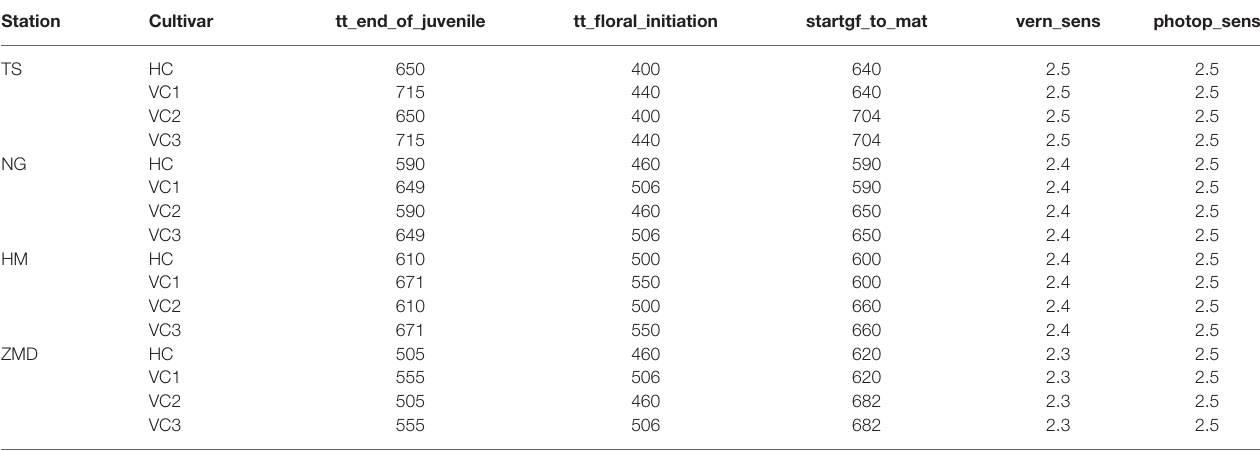
TABLE 4 | Phenological parameters for historical cultivar (HC) and three virtual wheat cultivars (VC1, VC2, and VC3) in the Agricultural Production System Simulator (APSIM)-wheat model. Station